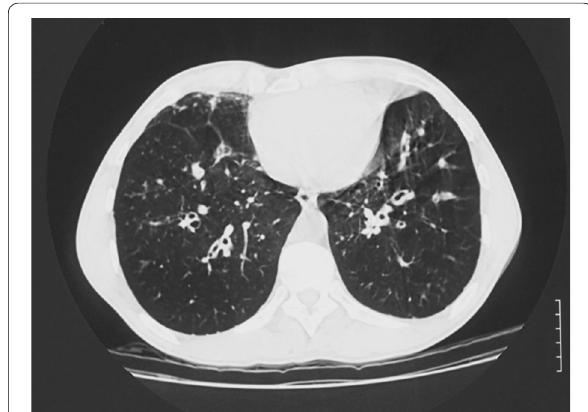
Fig. 1 Bronchiectasis complicating ABPA. Bilateral lower lobe bronchiectasis with marked bronchial wall thickening in most bronchi, but not all. Some distal air trapping and some tree in bud appearances